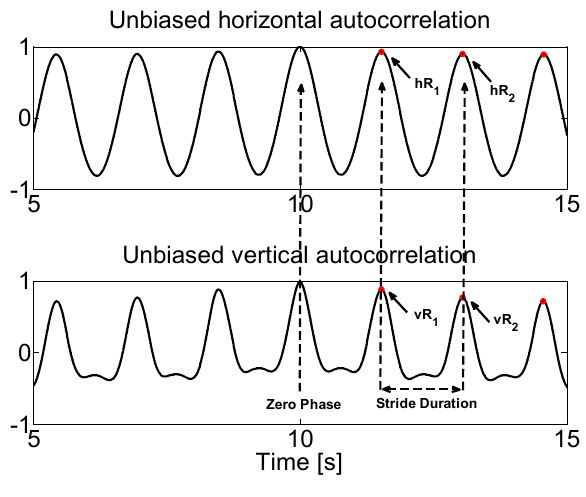
Figure 3. Horizontal and vertical unbiased autocorrelation plots of normal gait.